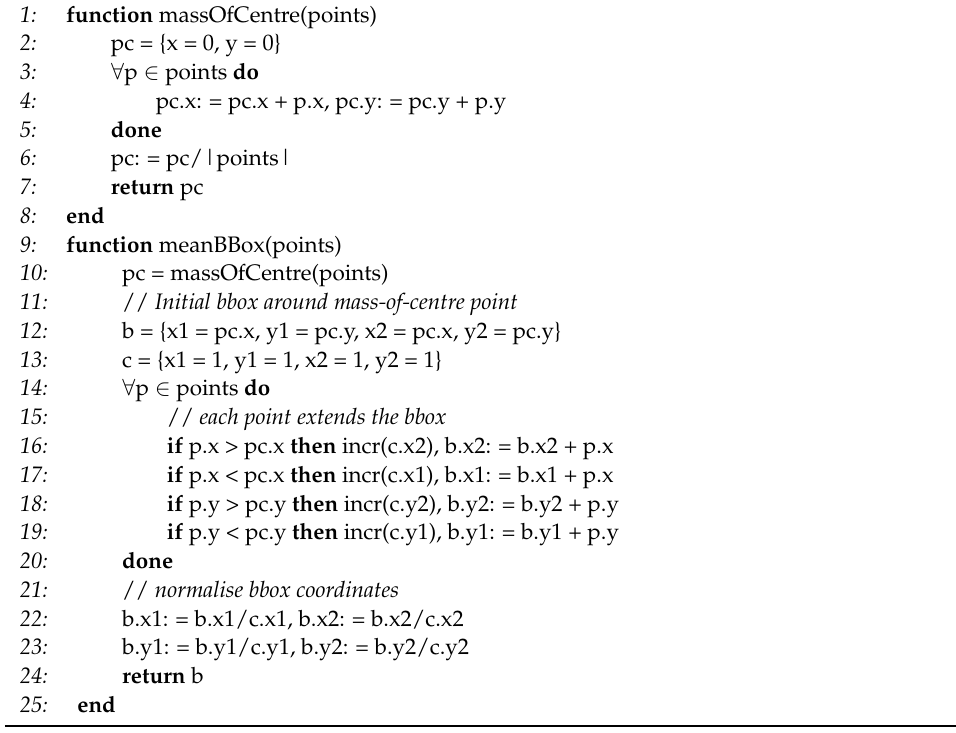
Algorithm 1 . Mean bounding box algorithm applied to a two-dimensional point cloud.